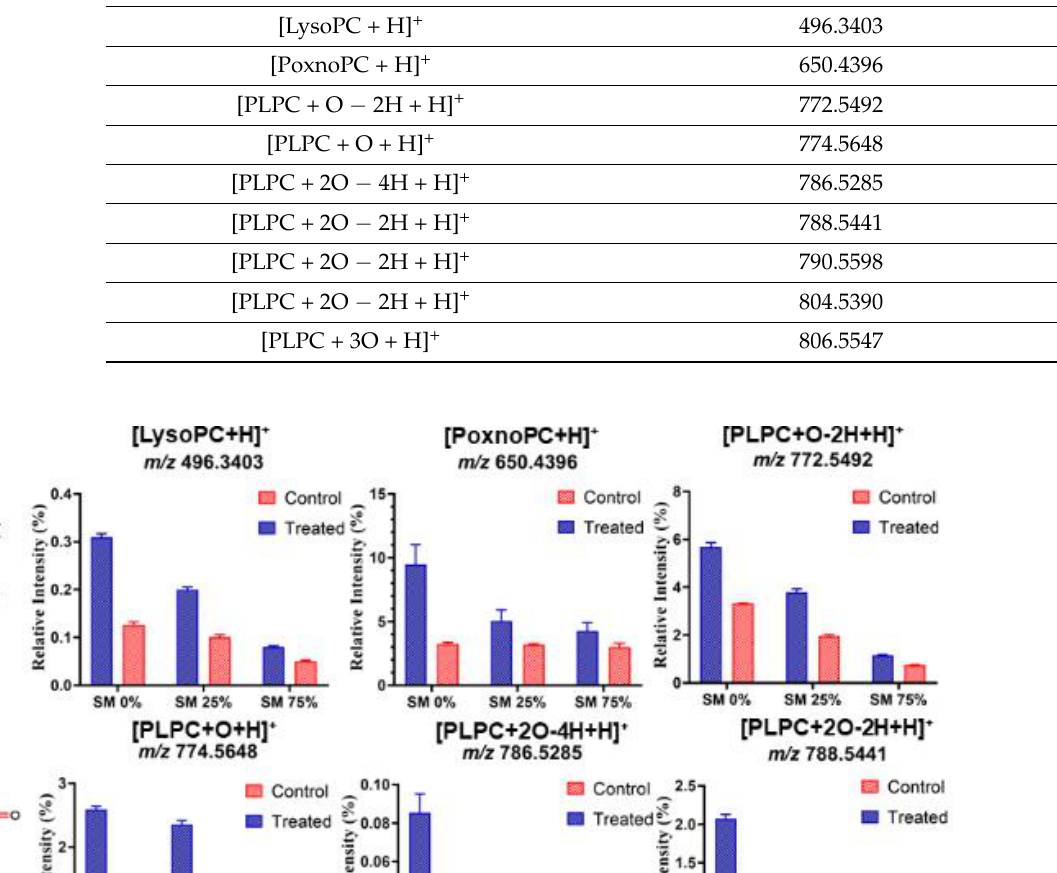
Table 2. PLPC peroxidation products after 30 min plasma treatments of lipid bilayers, observed by